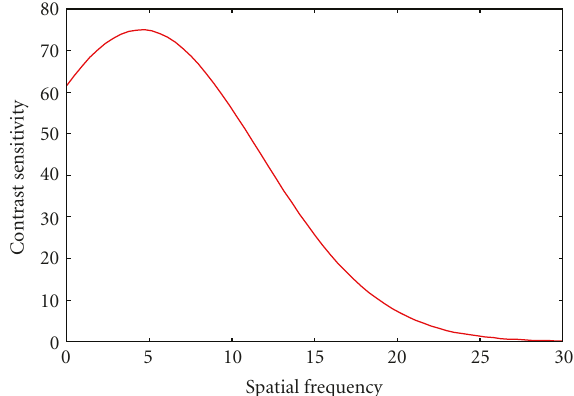
Figure 3: Shape of human visual MTF for luminance.